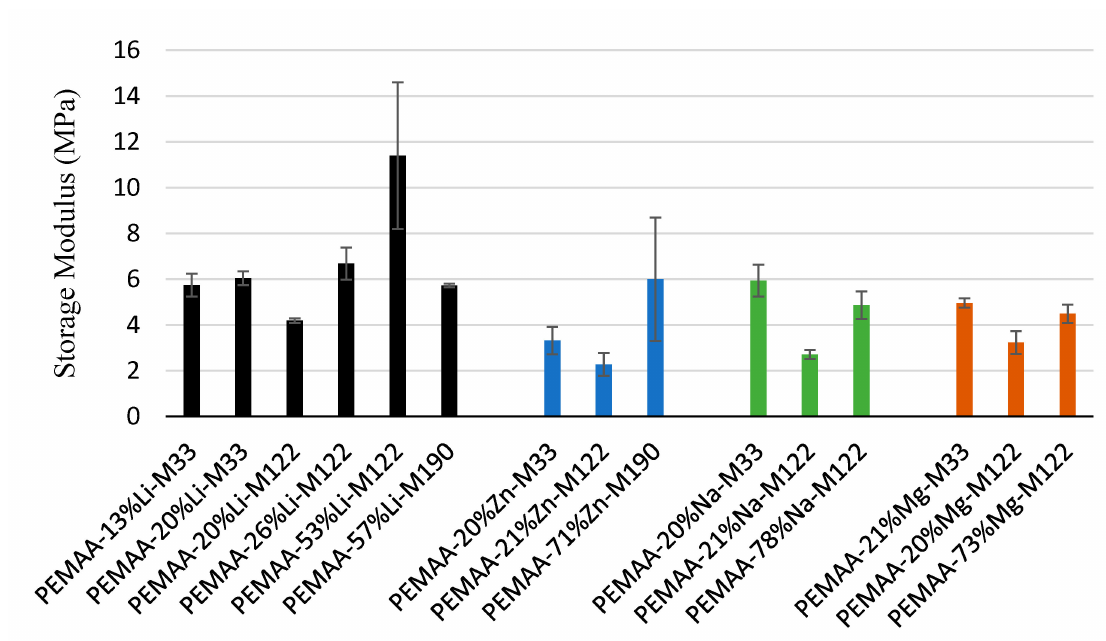
Figure 8. Storage modulus at 94.5 ◦ C for all PEMAA copolymers under investigation from DMA